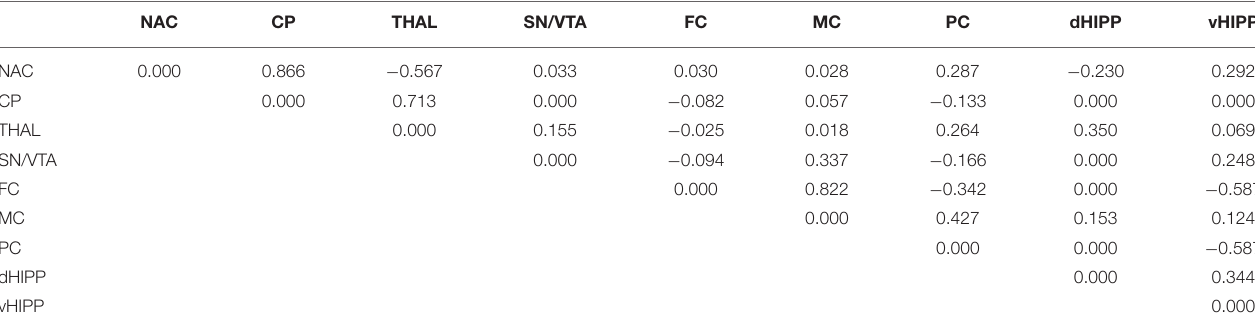
TABLE 2 | Path coefficient matrix after treatment with altanserin obtained with EBICglasso modeling of D 2 / 3 R binding potentials in nucleus accumbens (NAC), caudate putamen (CP), thalamus (THAL), substantia nigra/ventral tegmental area (SN/VTA), frontal cortex (FC), motor cortex (MC), parietal cortex (PC), dorsal hippocampus (dHIPP), and ventral hippocampus